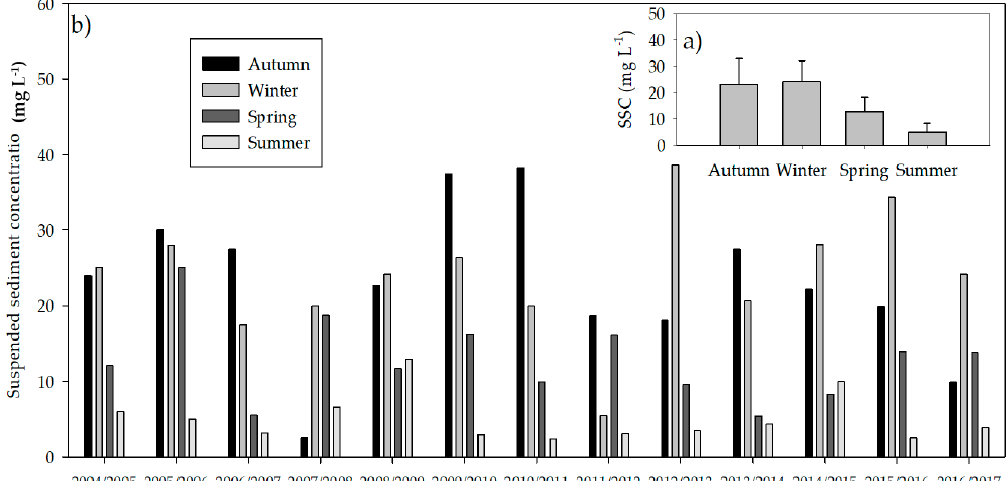
Figure 3. ( a ) Seasonal mean daily suspended sediment concentration (SSC) and standard deviation; ( b ) seasonal distribution of mean daily suspended sediment concentration during the study period.